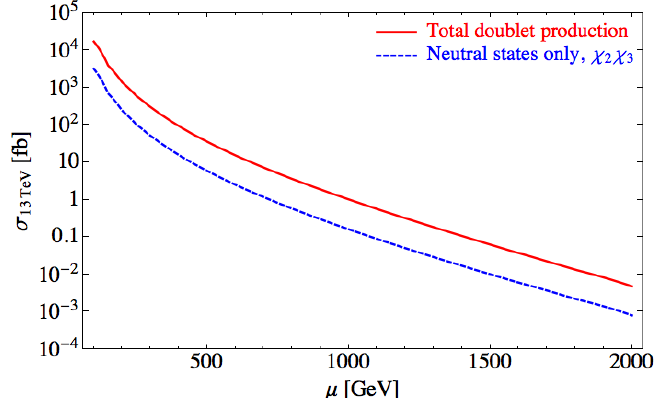
Figure 6 . NLO production cross section of the states belonging to the fermion doublet pair at p the LHC with s =13 TeV as computed by Prospino2 [101]. The solid red line indicates the sum over all possible production modes, while the dashed blue line shows the production cross section of the neutral states (cid:31) 2 (cid:31) 3